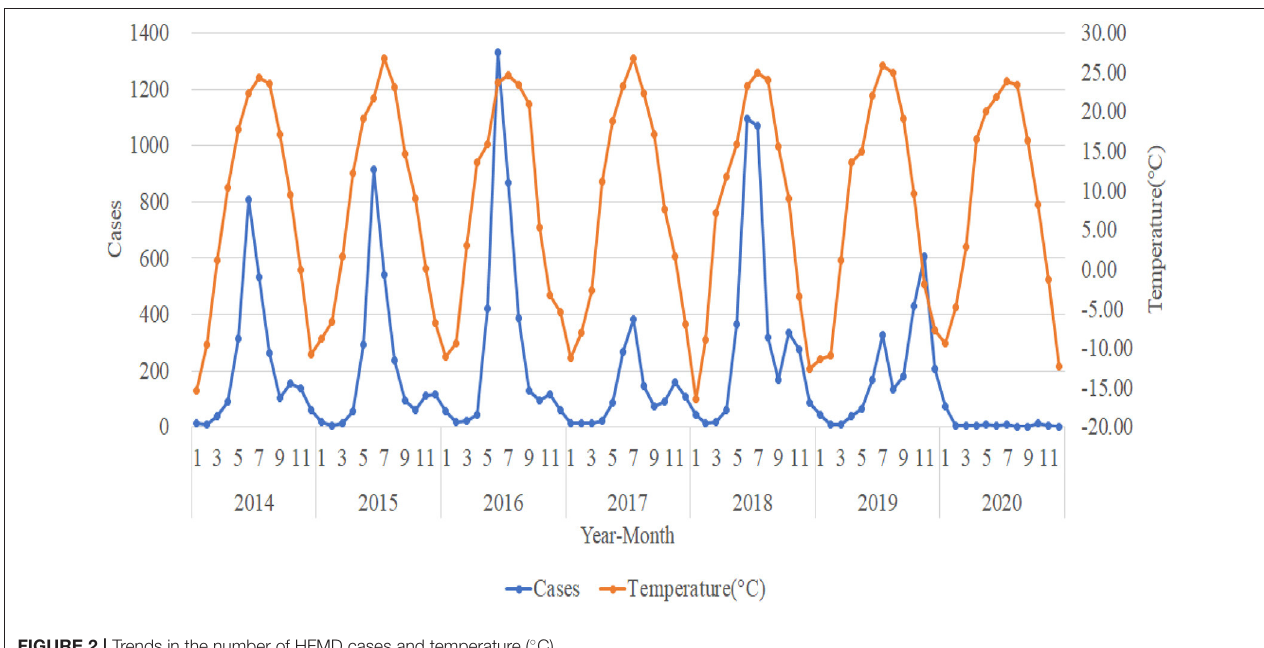
FIGURE 2 | Trends in the number of HFMD cases and temperature ( ◦ C).